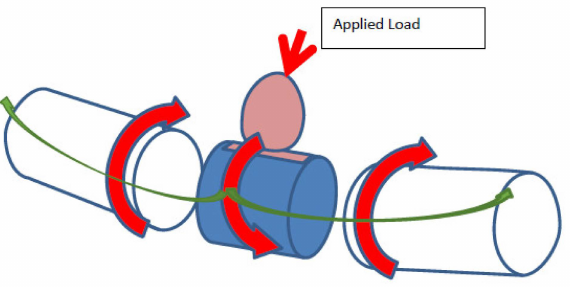
Figure 10. The buccal flexure of the body of the mandible dominated the readings of the buccal